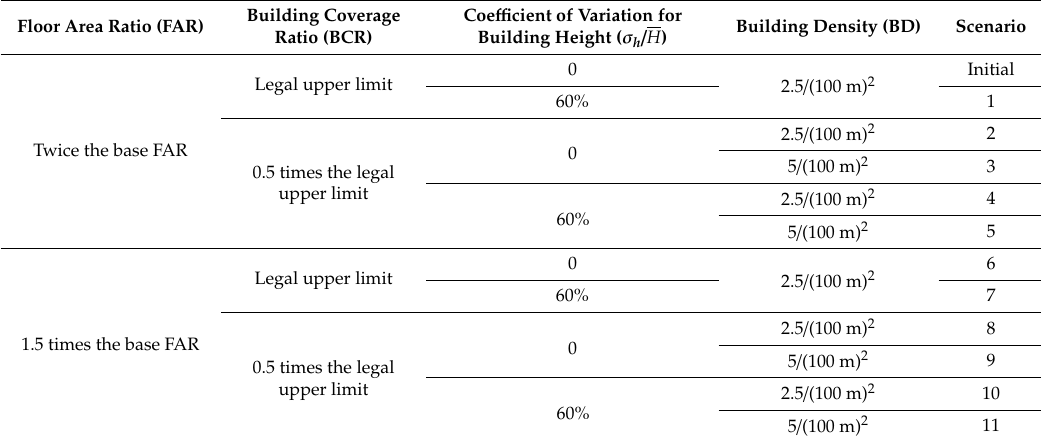
Figure 7. Examples of building model settings in simulation scenarios. Table 2. List of simulation scenario parameters.